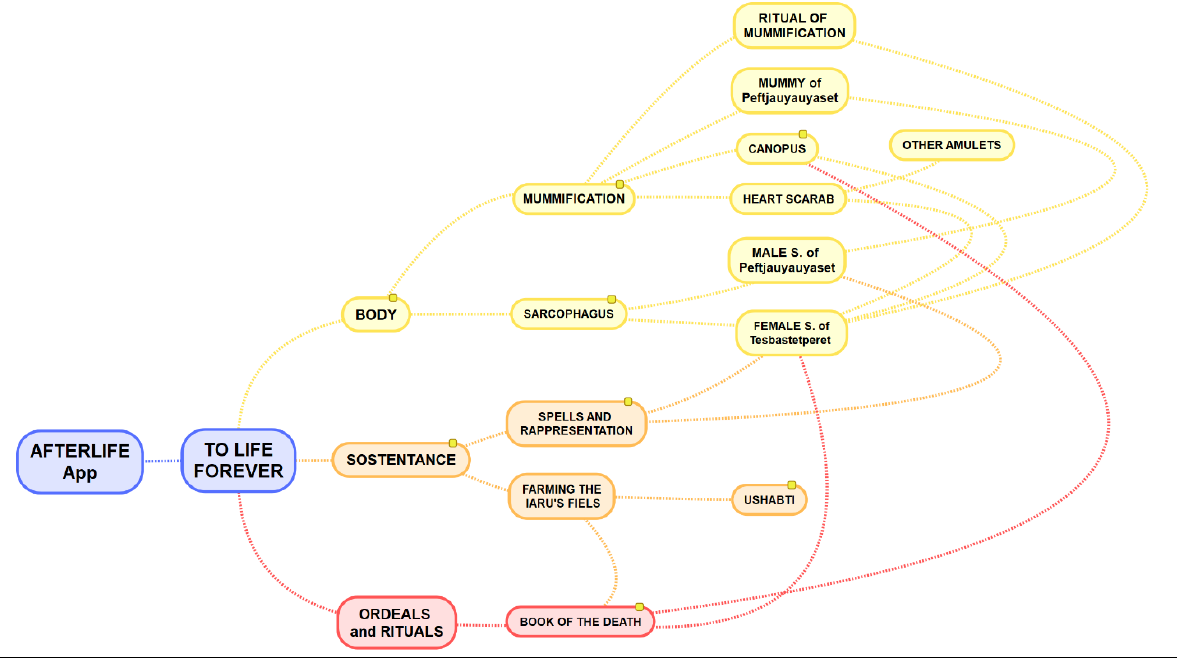
Figure 3. Logical diagram of the contents to be implemented in the interactive digital